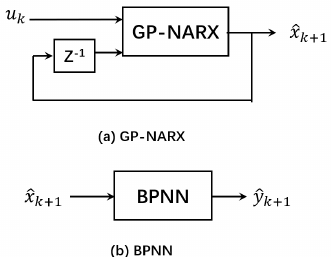
Figure 3. The state space model framework, where GP-NARX and BPNN are utilized in the state model and measurement model; ˆ x k + 1 and ˆ y k + 1 are the predicted values of x k + 1 and y k + 1